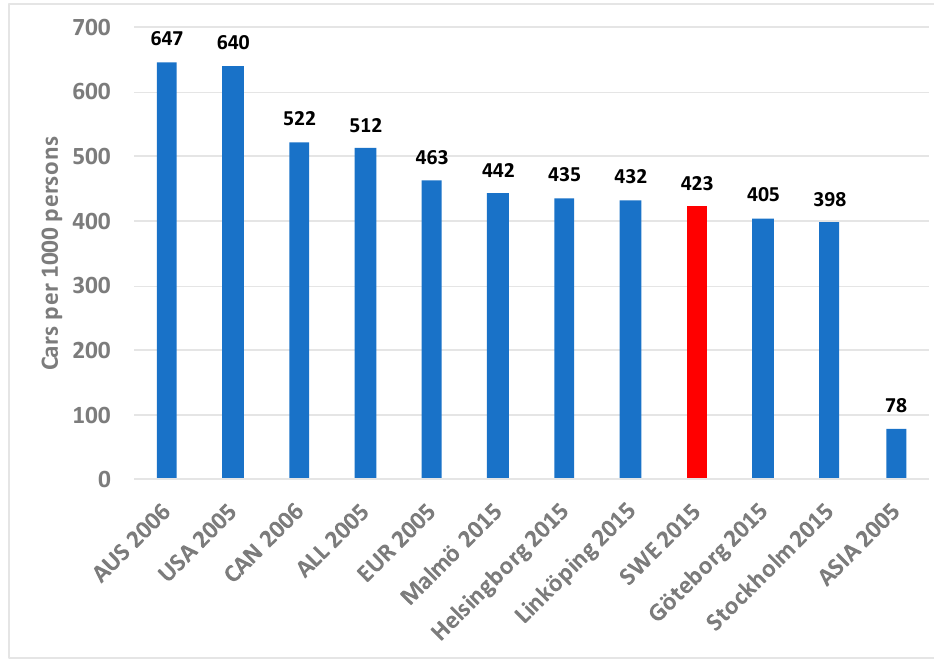
Figure 6. Car ownership in five Swedish cities (2015) compared to a sample of global cities (2005–2006).